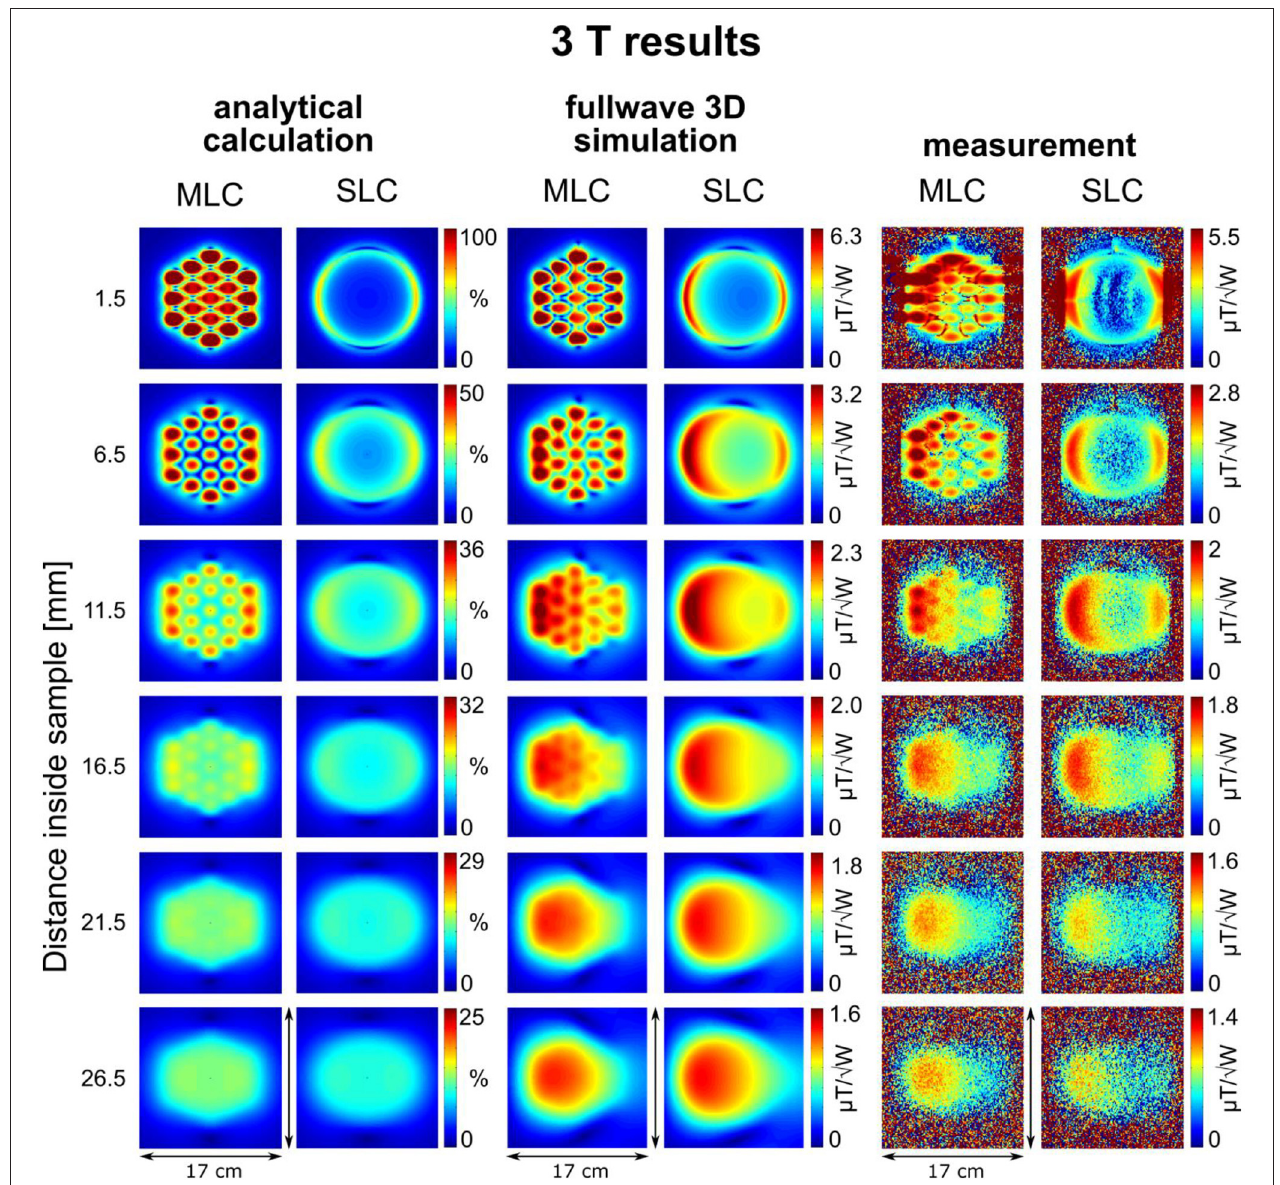
FIGURE 3 | Maps of the calculated sensitivity factor, as well as the simulated and measured transmit efficiency at different depths inside the sample for 3T coils. Calculated sensitivity factor values are normalized by the maximum sensitivity value obtained with the MLC at 1.5mm distance inside the sample.